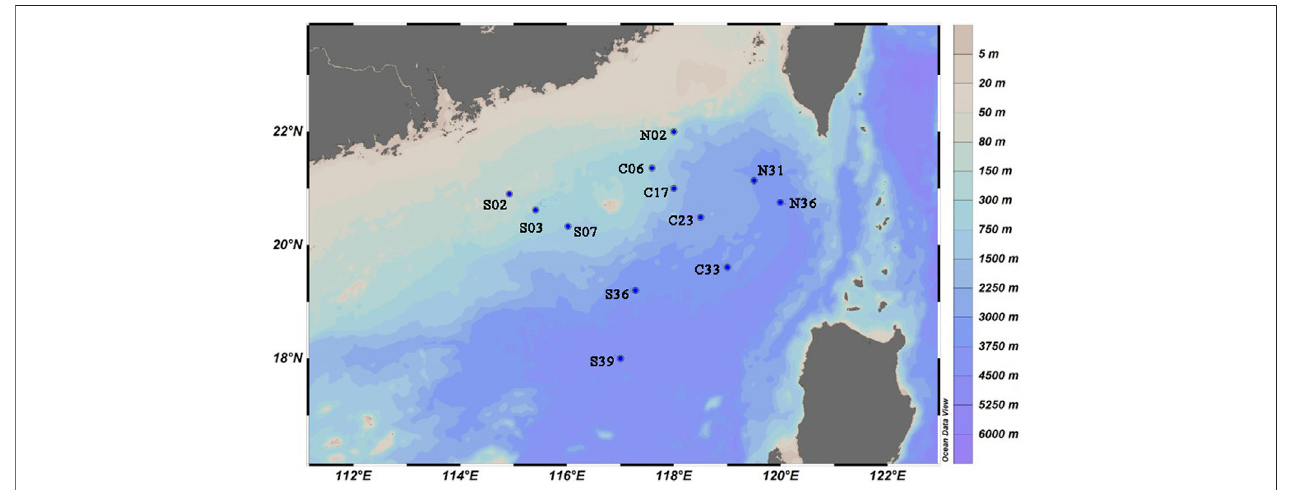
FIGURE 1 | Water depths (unit: m) and sampling points in the northeastern South China Sea.